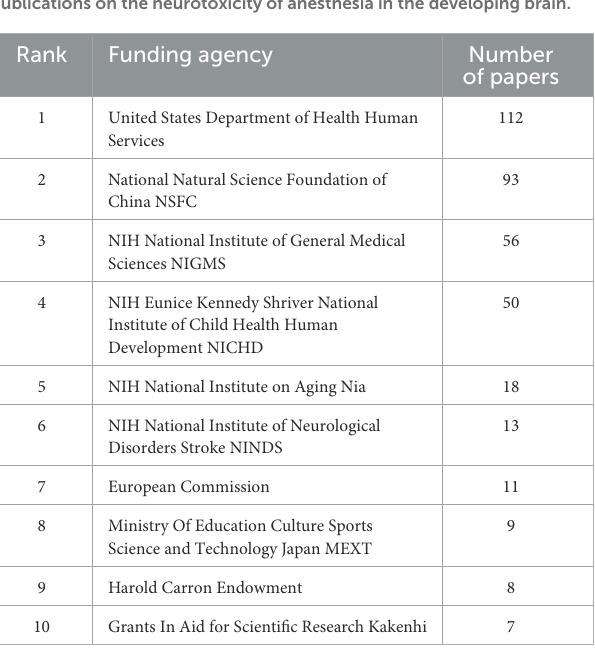
TABLE 5 The top 10 funding agencies with the highest number of publications on the neurotoxicity of anesthesia in the developing